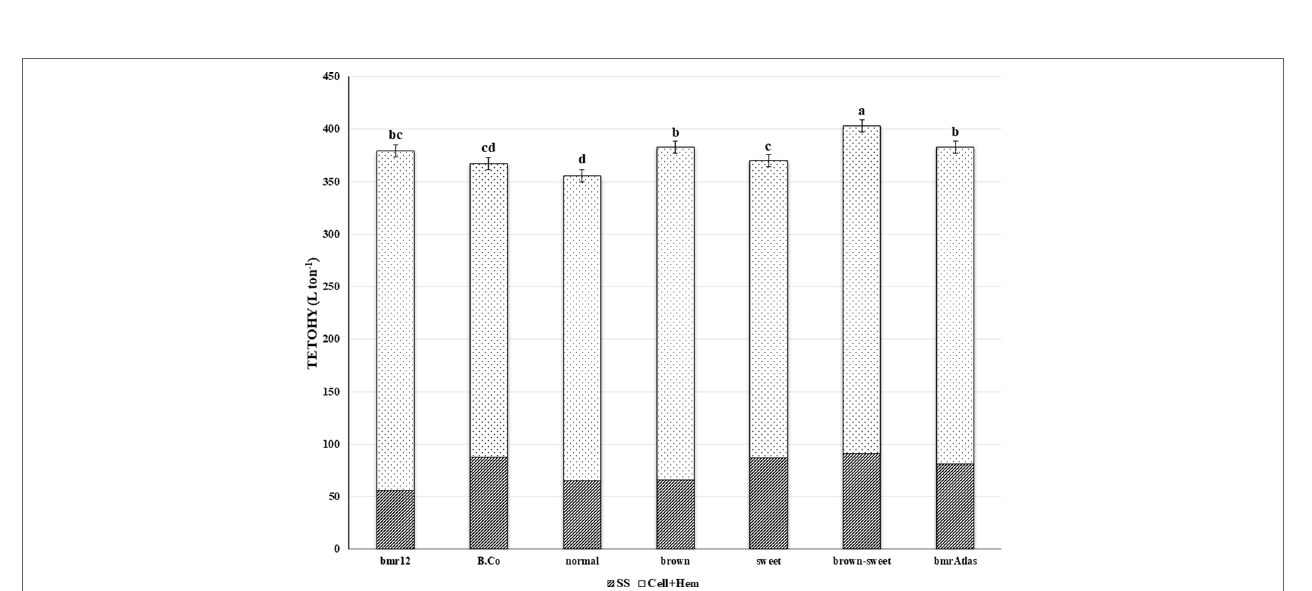
FIGURE 2 | Mean theoretical ethanol yield (TETOHY) from two sources of sorghum stover carbohydrates. Striped bars represent TETOHY from soluble sugars (SS) and the dotted bars represent TETOHY from cellulose and hemicellulose (Cell+Hem) estimates of bmr parent ( bmr12 ), sweet stem parent (B.Co), four RIL groups (“brown-sweet,” “brown,” “sweet,” and “normal”) and a commercial control ( bmr Atlas). Bars without the same letter are significantly different ( P < 0.05). Error bars represent ± one standard error of the